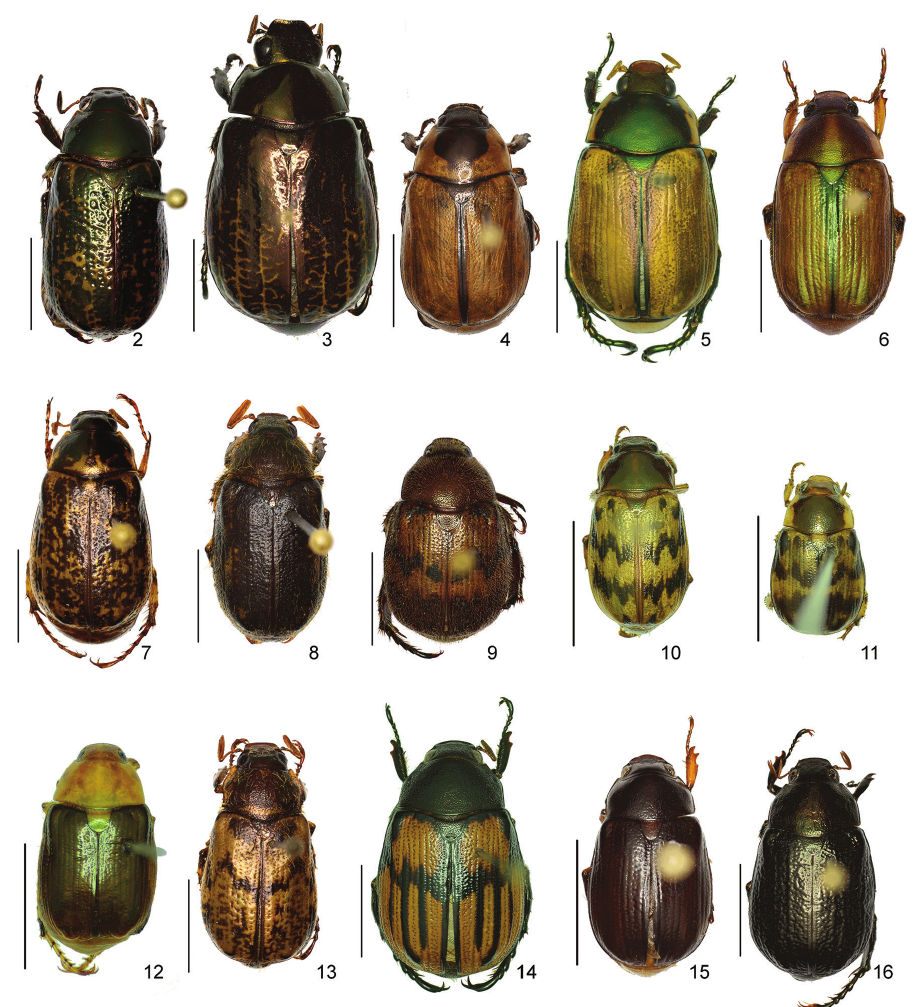
Figures 2–16. For each specimen is given the locality and province of recollection, and the collection where it is stored. Habitus. 2 Anomala aereiventris (Parque Nacional Tapantí, Cartago, MNCR) 3 A. aglaos (La Montura, San José, CEUA) 4 A. antica (Estación Palo Verde, Guanacaste, MNCR) 5 A. arara (Albergue Heliconias, Alajuela, CEUA) 6 A. arthuri (Estación Maritza, Guanacaste, MNCR) 7 A. asper- sa (Villa Mills, Cartago, MNCR) 8 A. atrivillosa (Estación Barva, Heredia, MNCR) 9 A. balzapambae (Reserva biológica Hitoy Cerere, Limón, MNCR) 10 A. calligrapha (Estación Cabro Muco, Guanacaste, CEUA) 11 A. chiriquina (Finca Cafrosa, Puntarenas, MNCR) 12 A. cinaedias (San Luis, Puntarenas, MNCR) 13 A. clarivillosa (La Esperanza, Cartago, CEUA) 14 A. clathrata (Estación Cabro Muco, Gua- nacaste, CEUA) 15 A. coffea (Estación Pitilla, Guanacaste, MNCR) 16 A. cupreovariolosa (Las Cruces, Puntarenas, MNCR). Scale bars: 5 mm. Figs 6, 16 from Filippini et al. (2014); Fig. 3 from Filippini et al. (2015b); Fig. 15 from Filippini et al. (2015c); Figs. 2, 7, 8, 13 from Filippini et al.